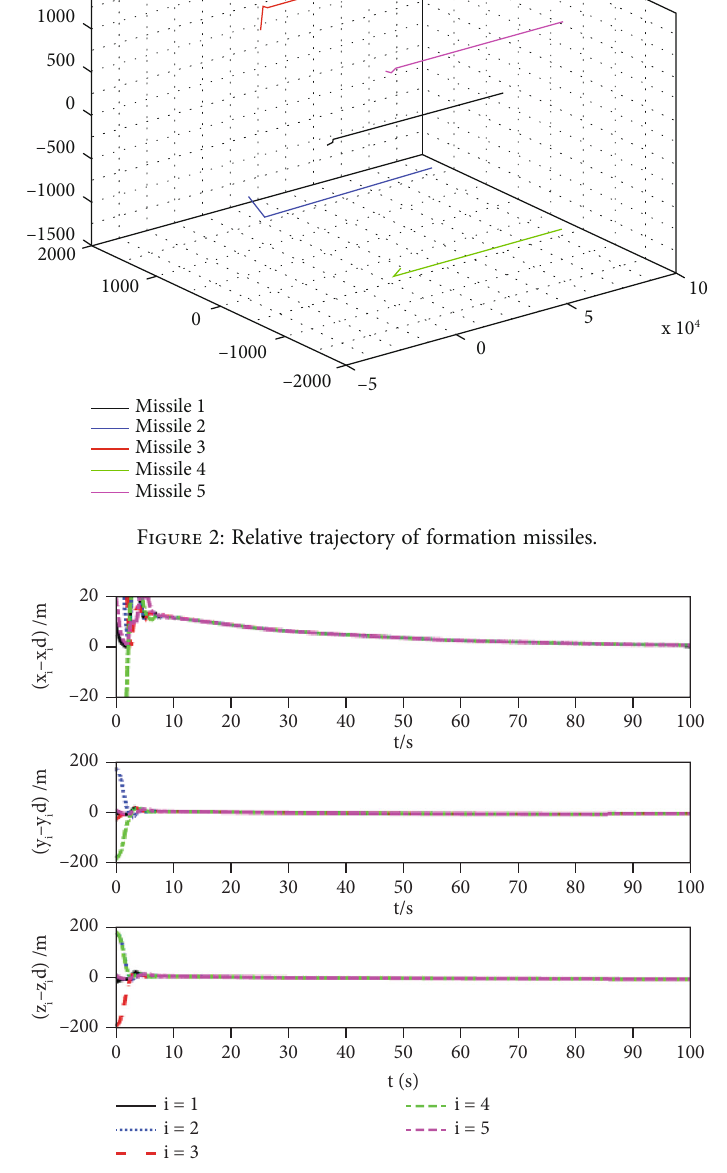
Figure 3: Missile position tracking